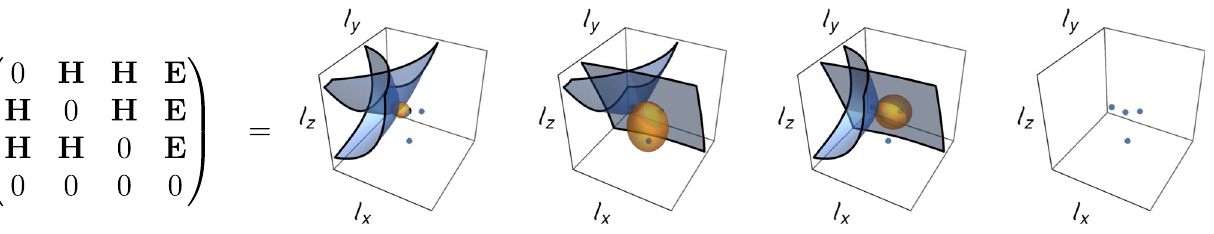
Fig. 4 Singularity matrix of a sample four-point function and the corresponding singularity surfaces of the dual integrands in the loop three- momentum